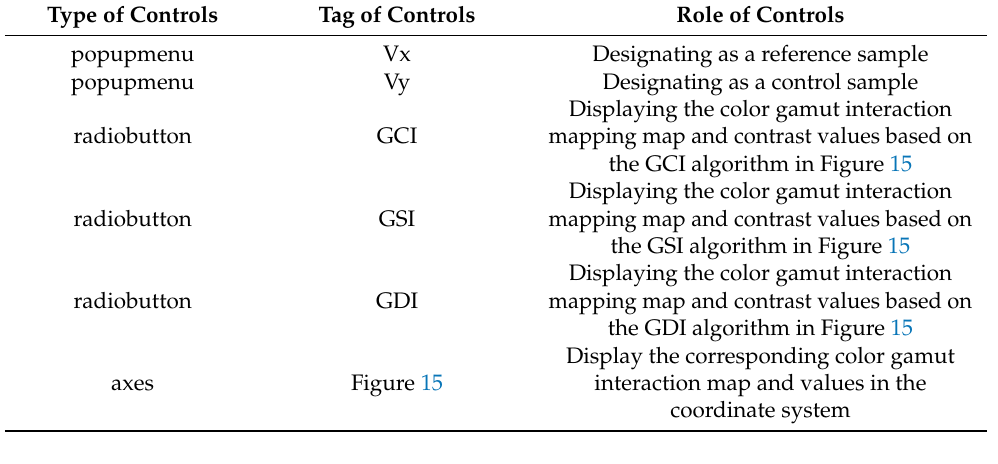
Table 5. Types, labels and roles of controls used in the Module 5 interface.